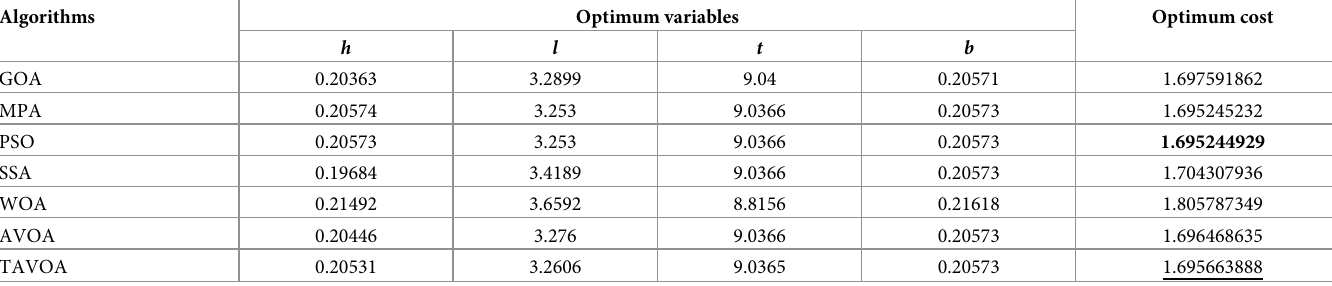
When TAVOA and the comparison algorithms obtain the best value in the compression/ tension spring design problem, the values of each variable are shown in Table 14. Table 13. Best results of the welded beam design problem.